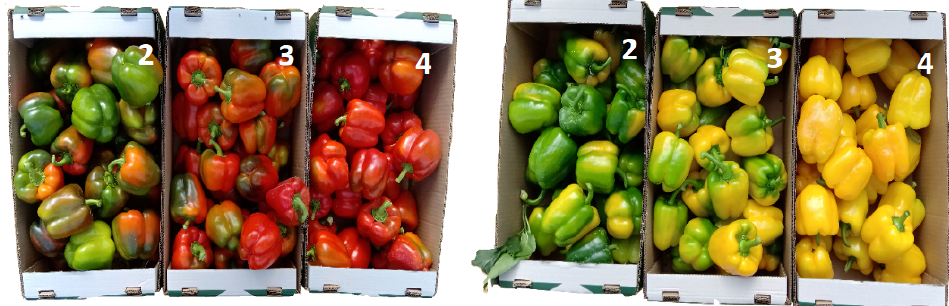
Figure 2. The red and yellow peppers used in the experiments (classes 2, 3, and 4, from left to right